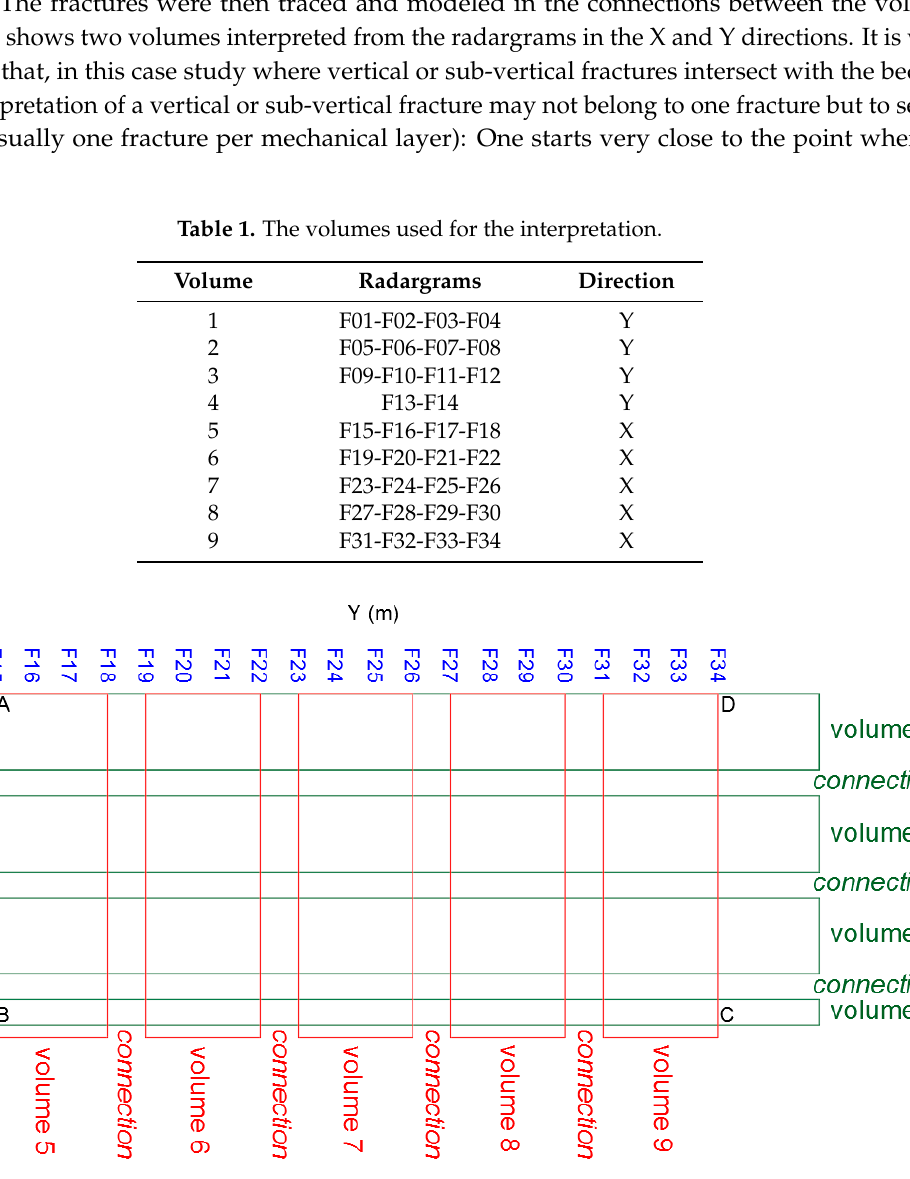
Figure 7. Graphical illustration of the volumes used for the interpretation (top view).